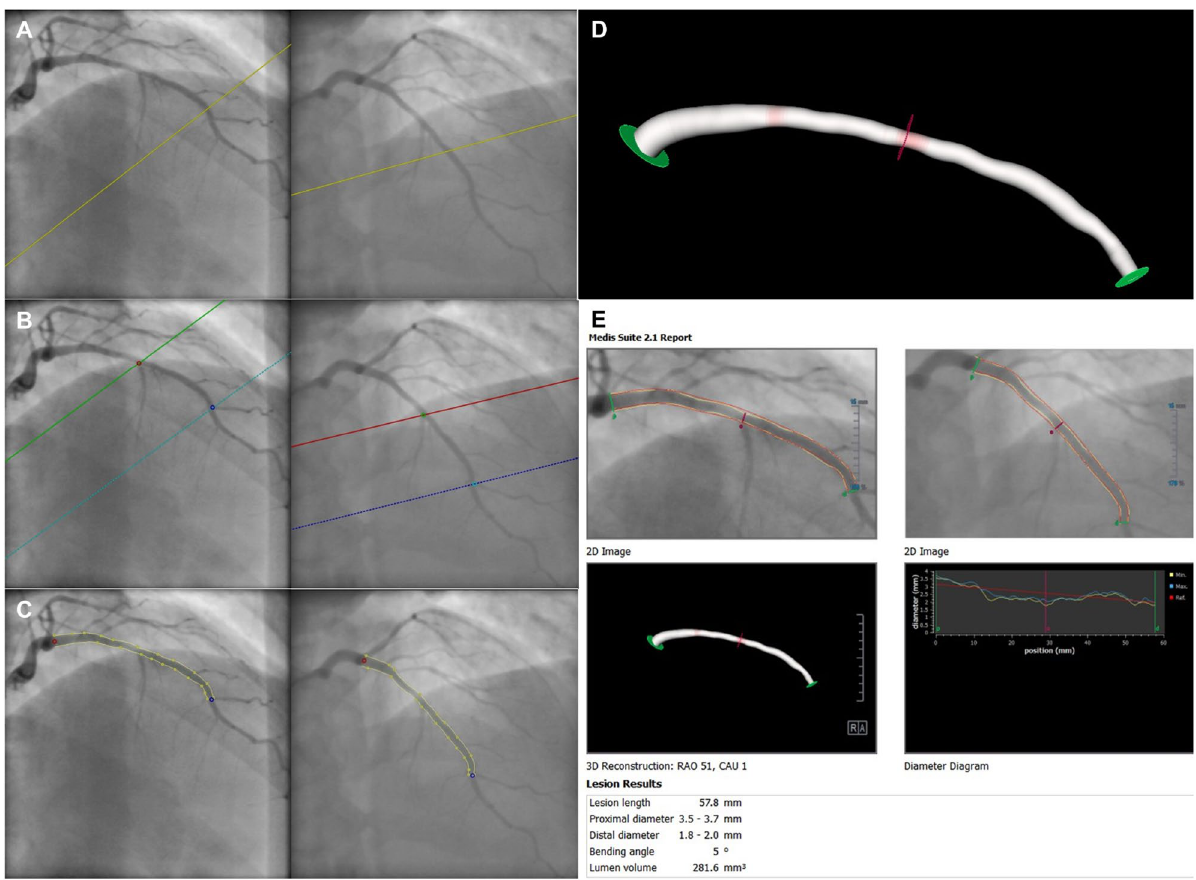
Figure 3. The process of 3D angiographic coronary artery volume reconstruction by 3D QCA. ( A ) Selection of the routine coronary angiography acquisition, two image sequences acquired at two angiographic views with projection angles at least 25° apart. ( B ) Identifying one to two anatomical markers such as bifurcations and side branches for automated correction of system distortions in the image geometry. ( C ) Manually defining the corresponding start and end positions of the interested vessel segment and extracting its contours and centerline. ( D ) Automating 3D coronary artery reconstruction of the vessel segment of interest. ( E ) Final 3D QCA report, including coronary volume, length, and proximal and distal diameter of the segment of interest. The diameter analysis includes a minimum (yellow line), maximum (blue line) and reference (red line) dimension. Abbreviations: QCA quantitative coronary